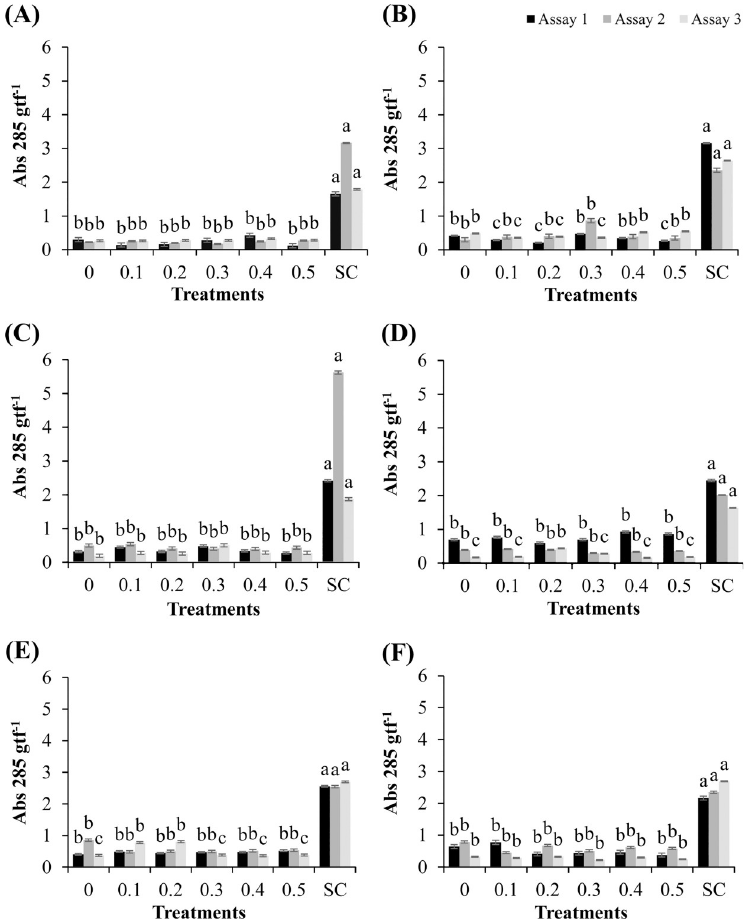
Fig 1. Synthesis of glyceollins in soybean cotyledons treated with different concentrations of R . guttatus and R . marina (0.1, 0.2, 0.3, 0.4, and 0.5 mg/mL), sterile water (0), and S . cerevisiae (SC). Cultivars treated with R . guttatus cutaneous secretions (species 1): ( A ) ‘Monsoy 8372 IPRO’; ( B ) ‘TMG 132 RR’; and ( C ) nontransgenic ‘TMG 4182’. Cultivars treated with R . marina cutaneous secretions (species 2): ( D ) ‘Monsoy 8372 IPRO’; ( E ) ‘TMG 132 RR’; and ( F ) nontransgenic ‘TMG 4182’. The experiments were performed three times for each treatment. The same letters indicate absence of significant differences by the Scott–Knott test at P � 0.05. Metric bars indicate the standard error of the mean (SE). Data were transformed as follows: ( x +1) 0.5 .